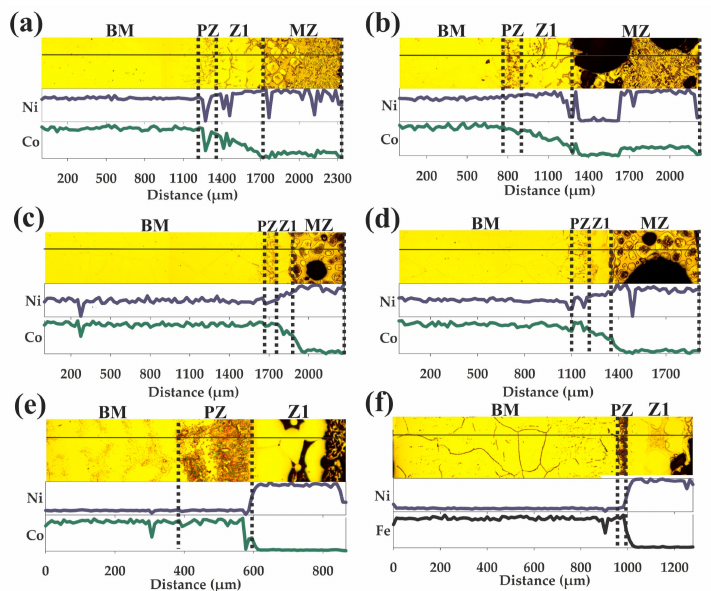
Figure 14. Linear profile by Energy Dispersive X-Ray Spectroscopy of Ni and Co or Fe in the central section of drop-samples of the di ff erent alloys studied: ( a ) Sol-Wasp, ( b ) Age-Wasp, ( c ) Ni-Sol-Wasp, ( d ) Ni-Age-Wasp, ( e ) FSX-414 and ( f ) 304-SS. In the two latter ones, there is not an MZ, because they were fully solidified, while some porosity is still present.